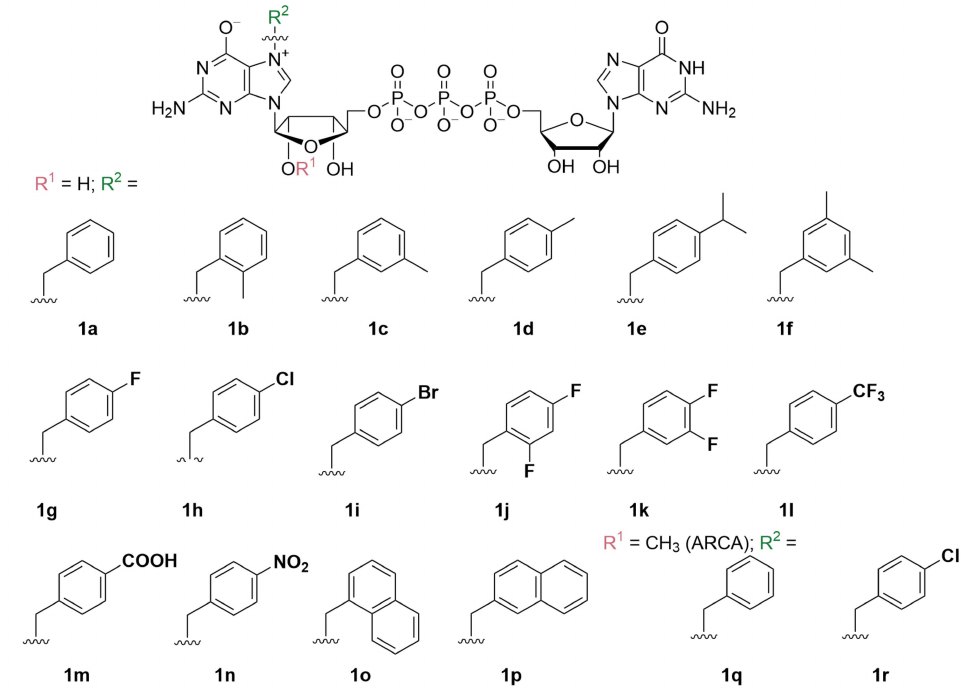
Figure 1. Structures of dinucleotide cap analogs synthesized and studied in this work. ARCA: anti-reverse cap